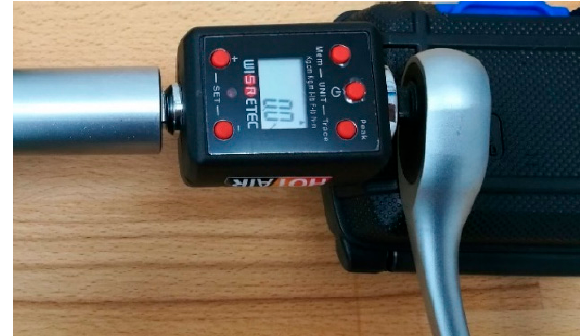
Figure 6. Torquemeter WRG3-135 (from 6.8 to 135 Nm).